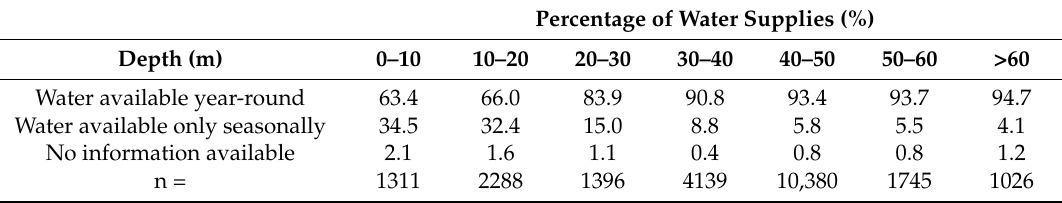
Table 3. Percentage of Stranded Assets where water is only seasonably available from the improved rural water supply as a function of supply borehole